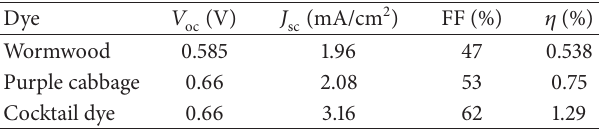
Table 1: Photoelectrical parameters of DSSCs sensitized by chloro- phyll, anthocyanin, and cocktail dye.